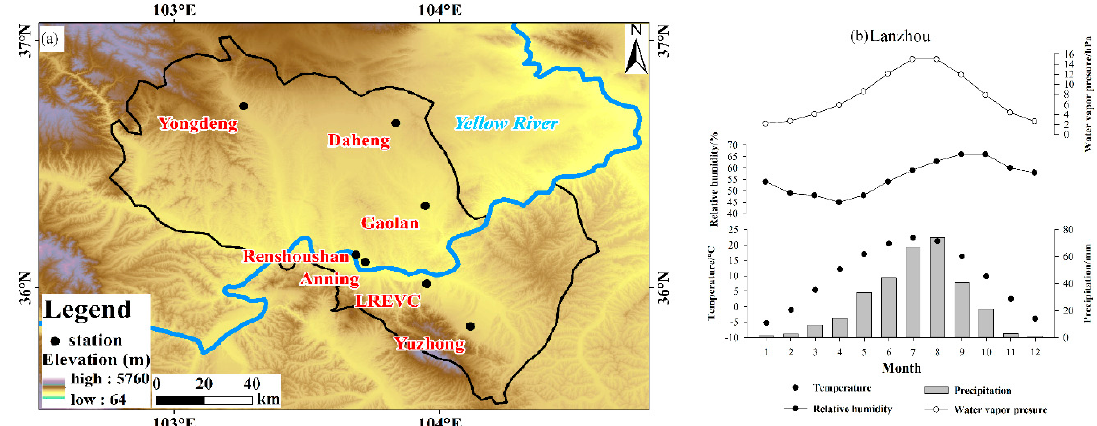
Figure 1. ( a ) Spatial distribution of sampling sites in Lanzhou city; ( b ) Monthly variation of air temperature, precipitation amount, relative humidity and water vapor pressure in Lanzhou city during 1981–2010. Table 1. Latitude, longitude and altitude of sampling stations in Lanzhou city used in this study.